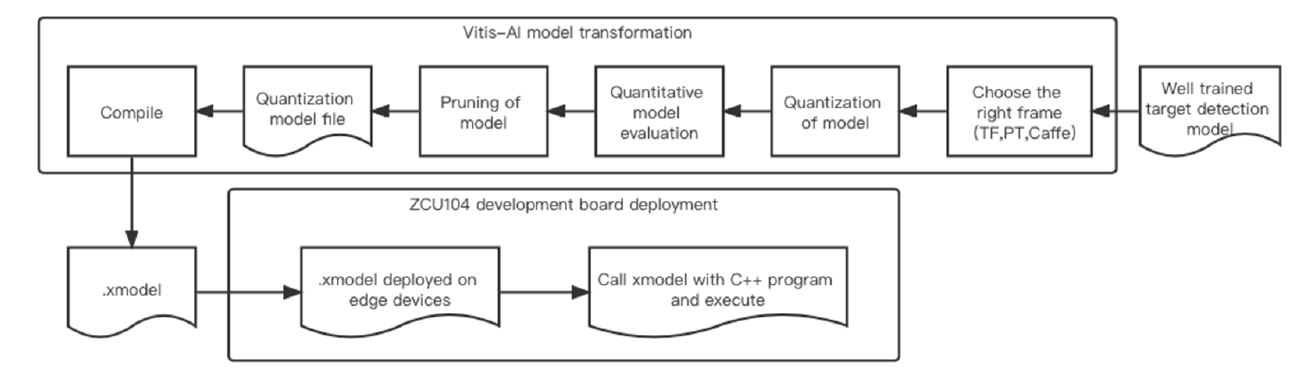
Figure 12. Flowchart of algorithm DPU deployment.